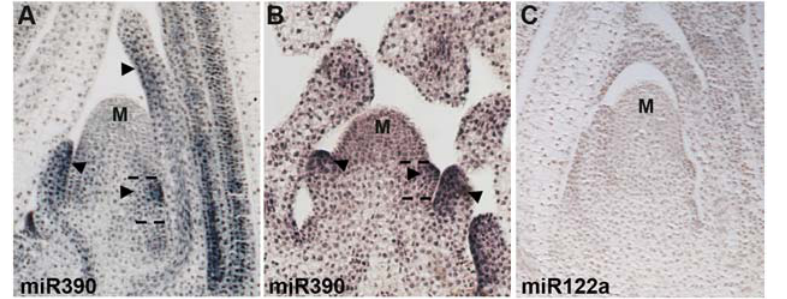
Figure 3. MiR390 is an upstream component in the maize leaf polarity pathway. (A, B) In situ hybridization analyses with a miR390 complementary LNA probe shows this small RNA accumulates on the adaxial side (arrowheads) of incipient and developing leaf primorida of both wild-type (A) and lbl1-rgd1 (B) seedlings. Dashed lines mark the position of the incipient leaf. No hybridization signal is detected in the tip of the wild- type SAM. (C) In situ hybridization with an LNA-probe complementary to murine miR122a serves as a negative control.